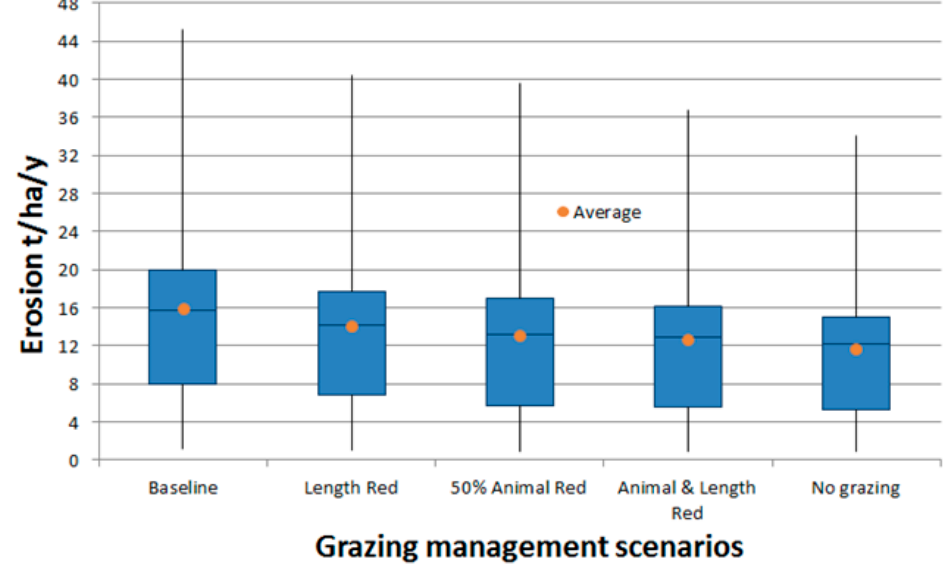
Figure 4. Box plots of annual soil loss in Samothraki Island under various grazing management scenarios from the 21-year period between 1986–2006 simulated.